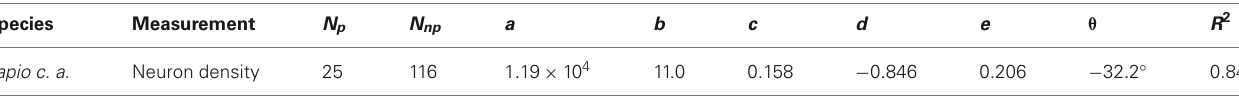
Table 4 | Parameters for curve-fitting of neuron density and neurons per unit column. Species Measurement N a b c d θ R 2 Otolemur g . Neurons per column 35 5 . 41 × 10 4 Neuron density Papio c. a . Neurons per column 141 Neuron density Macaca m . Neuron density